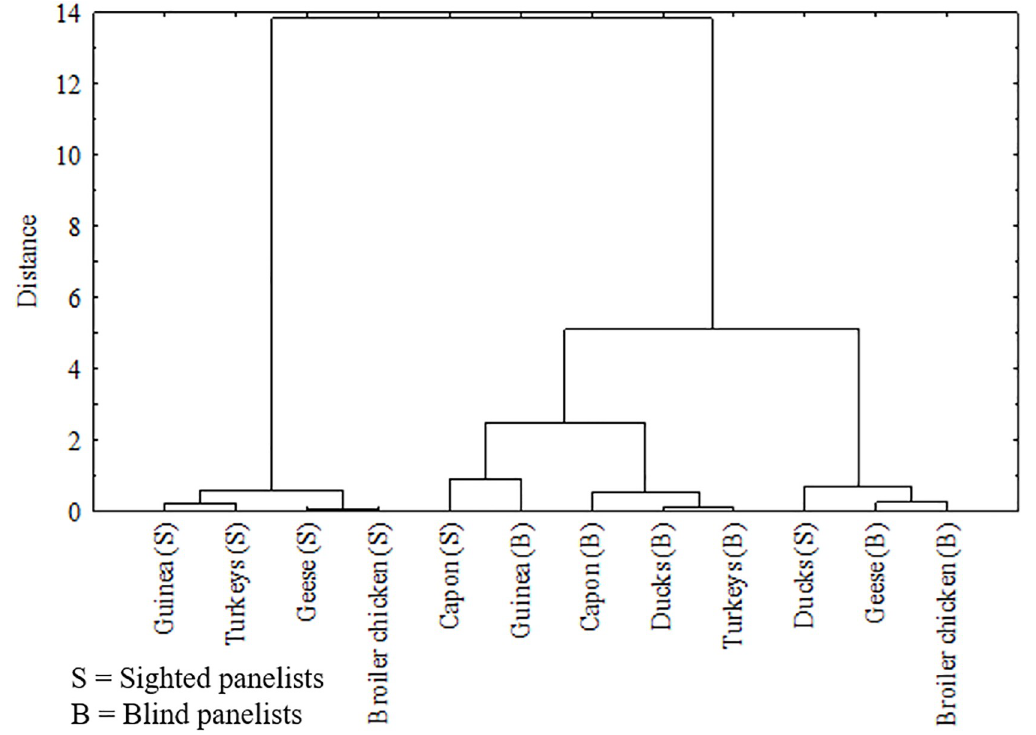
Fig 8. Dendrograms based on cluster analysis using Ward’s method using five examined traits poultry leg meat, ie. smell, taste, tenderness, juiciness and overal liking.